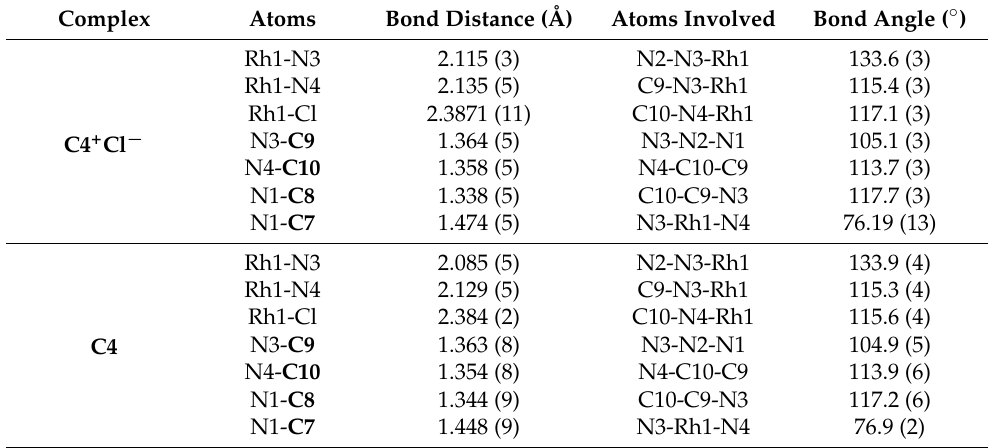
Table 1. Selected bond lengths and bond angles for complex C4 and related chloride analogue ( C4 + Cl −